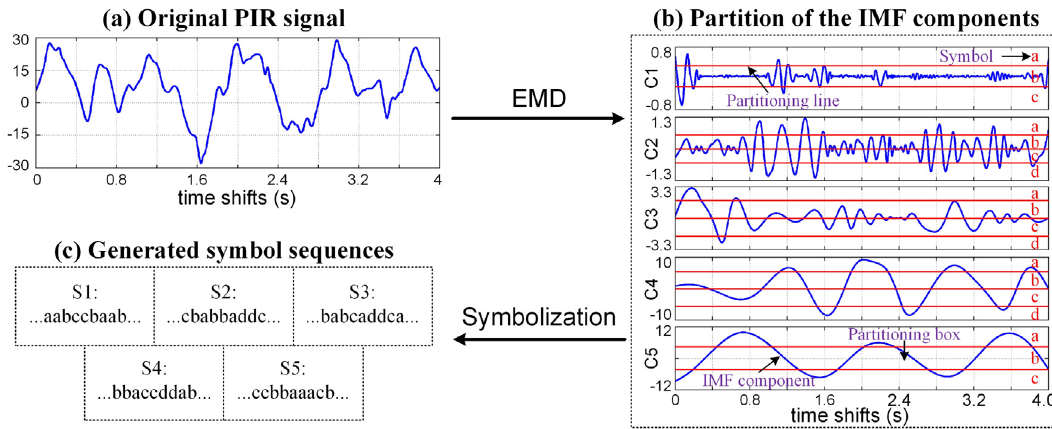
Figure 6. Illustration of the EMD-based symbolization method, where C i indicates the i th IMF component and S i indicates the symbol sequence generated from C i .